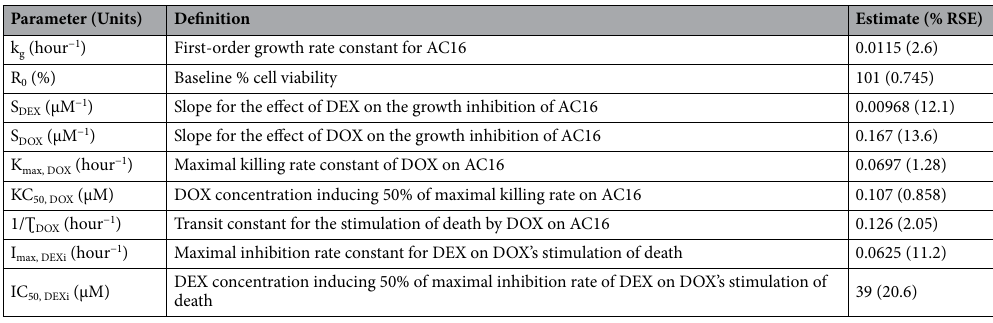
Table 1. Parameter estimates for the in vitro cellular-level toxicodynamic model (TD) for the single and combinatorial effects of Doxorubicin (DOX) and Dexrazoxane (DEX) on AC16 human cardiomyocytes. % RSE = % relative standard error in the model